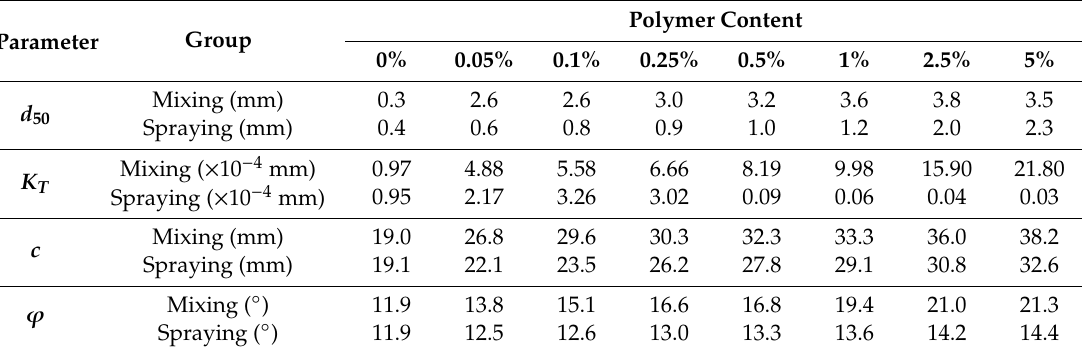
Table 3. Parameter changes after soil sample